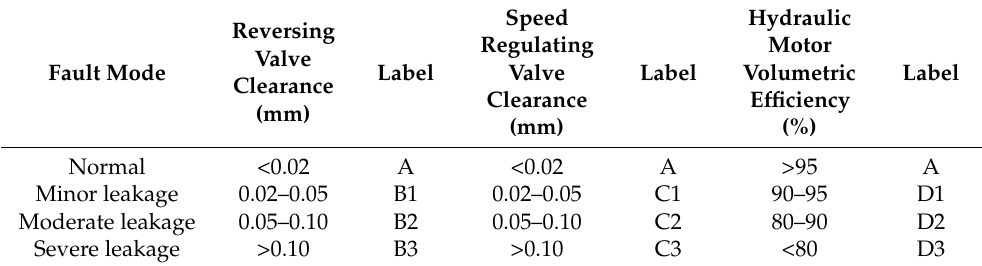
Table 8. Hydraulic system leakage fault mode.